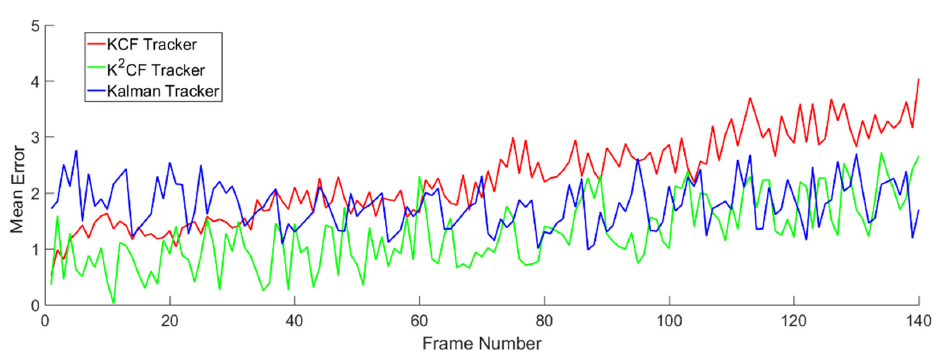
Figure 13. Detection errors of the trackers for a target with uniform velocity.